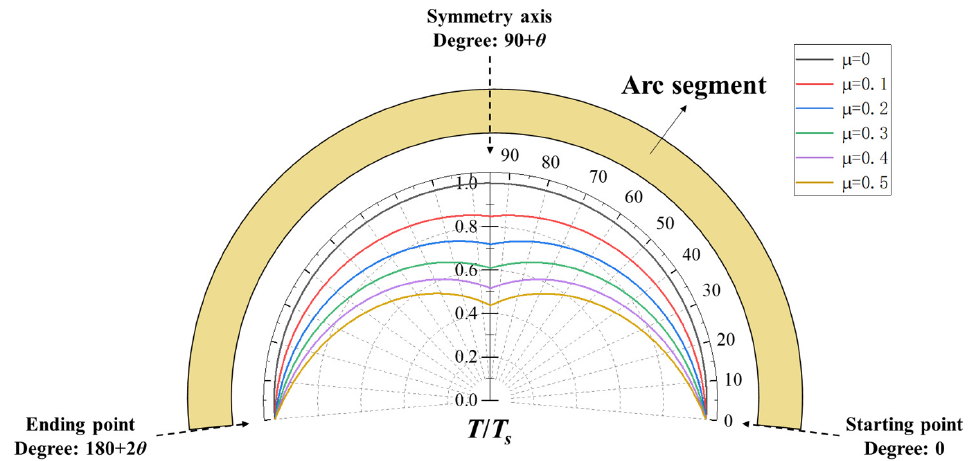
Figure 4. Tension distribution of the arc under different friction coefficients.